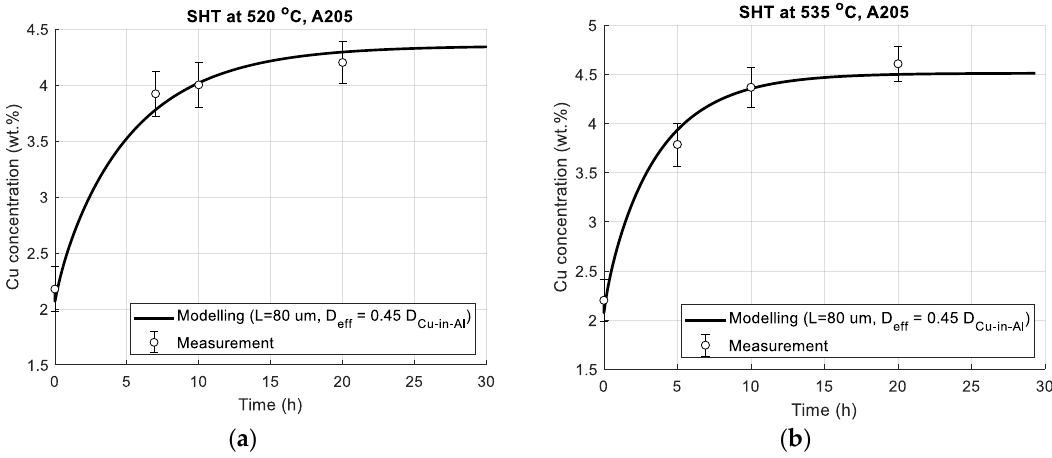
Figure 13. Simulated and measured Cu concentration in the matrix during solution heat treatment of A205 ( a ) at 520 ◦ C and ( b ) at 535 ◦ C; in the models: L = 80 µ m, D e ff = 0.45 · D Cu-in-Al